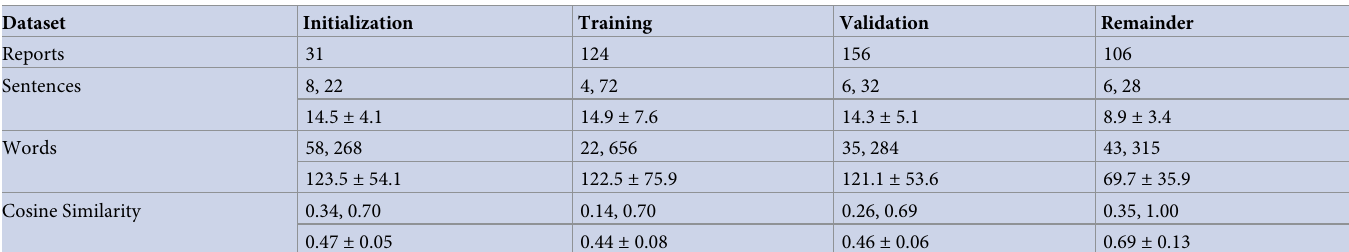
Table 1. Radiology report characteristics.